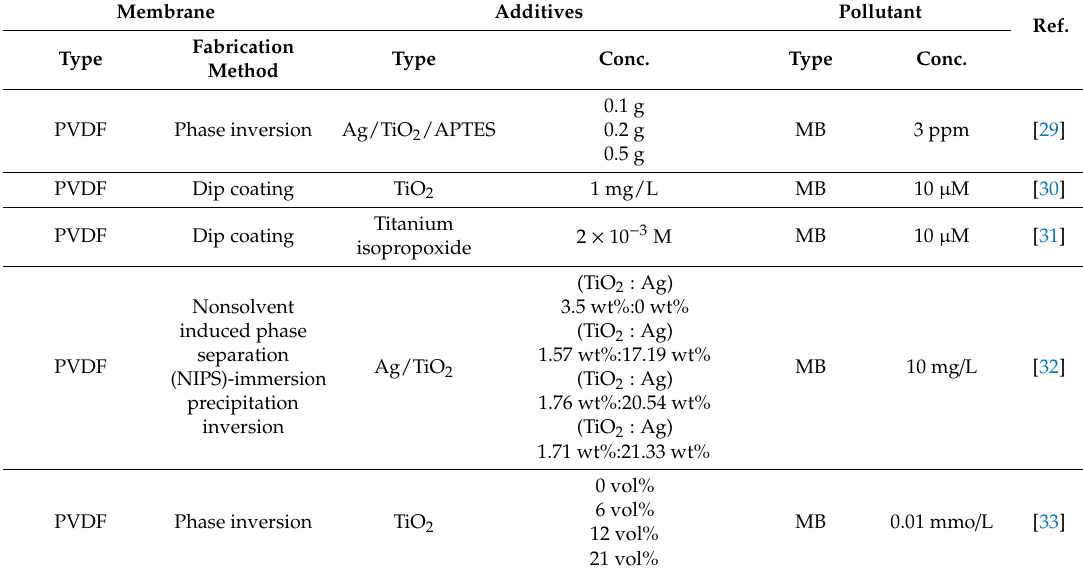
Table 2. Electrospinning condition for preparation of PVDF membrane.